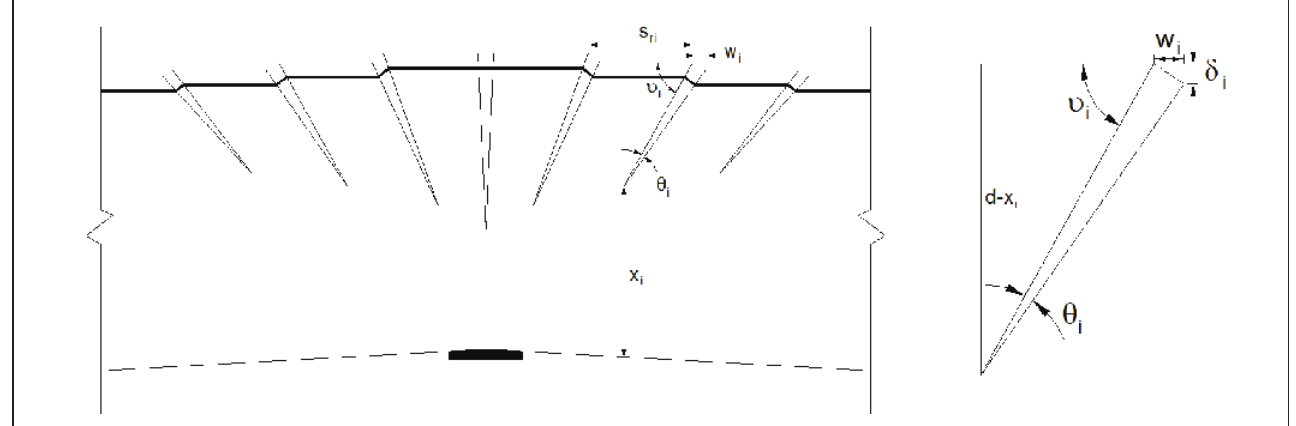
Figure 3 – Bachmann's method for computing the rotation (example of a region over a support)